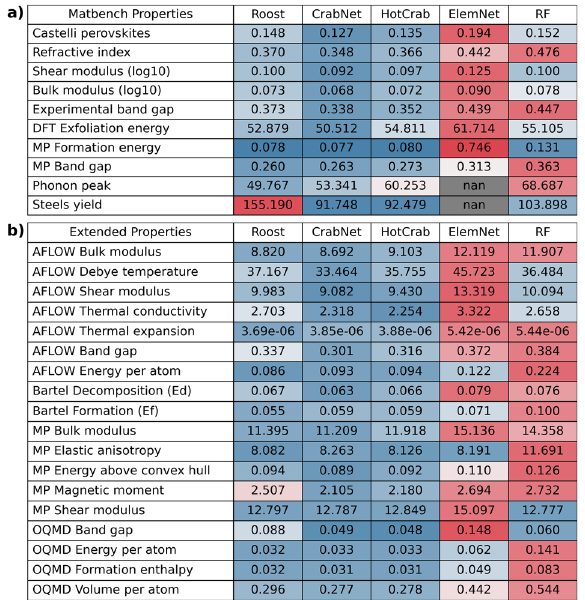
Fig. 1 Benchmark results. MAE scores of Roost , CrabNet , one- hot encoded CrabNet ( HotCrab ), and ElemNet on the held-out test datasets, compared with the random forest ( RF ) baseline for ( a ) the Matbench dataset and ( b ) the Extended dataset. Cells are colored according to relative MAE performance within each row (blue is better, and red is worse). A NaN (not a number) value is reported for instances where the models failed to converge on a given material property. Here we present model results trained using chemical information ( Roost , CrabNet ), no chemical information ( HotCrab , ElemNet ), and a standard CBFV ( RF ).